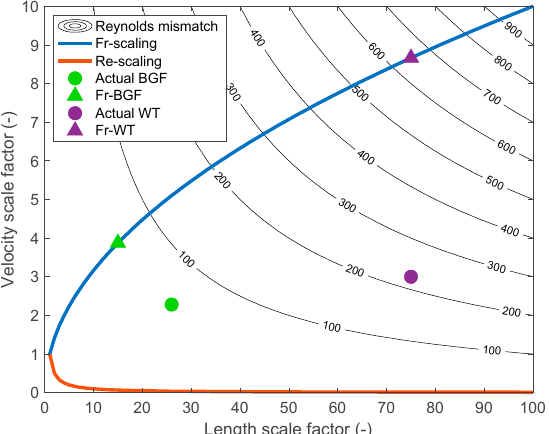
Figure 1. The Reynolds mismatch (reduction with regard to full-scale) as a function of the length and velocity scale factors. The blue and orange lines correspond to the Froude and Reynolds scaling, respectively. Markers show the Blue Growth Farm (BGF) model scaling (green) and wind tunnel model scaling (purple), with “Fr-x” corresponding to the scale factors where Froude scaling was used and “Actual x” corresponding to the adopted scale factors. Table 2. Scale factors for the wind turbine model for wind tunnel testing: Politecnico di Milano.